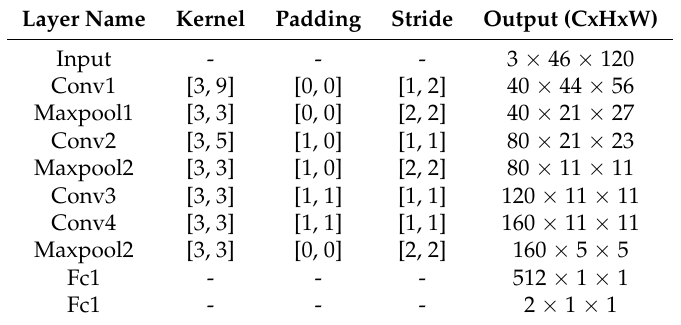
Table 1. Detailed description of the customized DCNN for parking slot occupancy classification. Layer